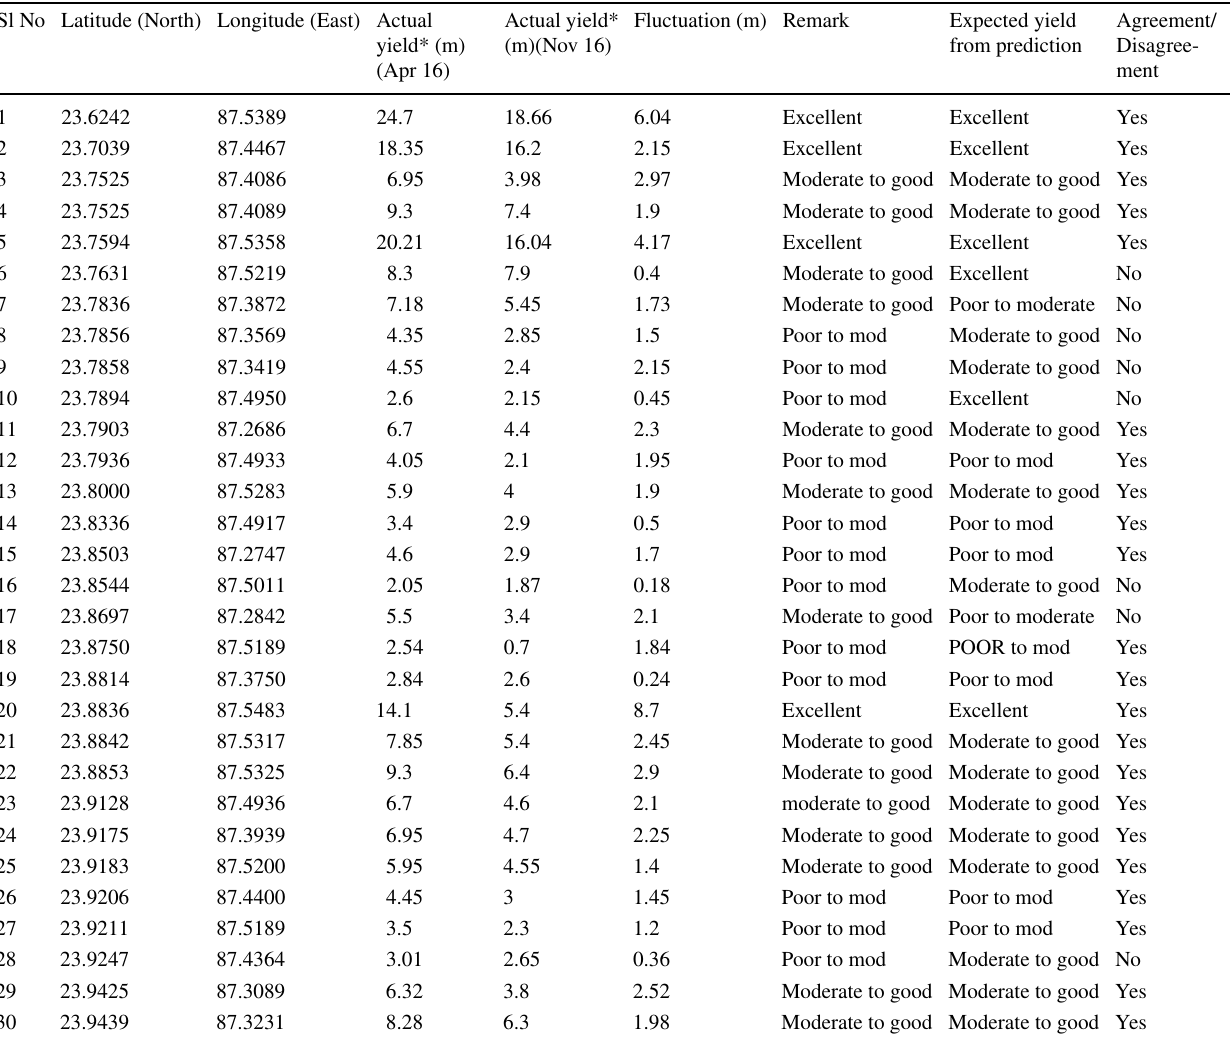
*Source: Central Ground Water Board